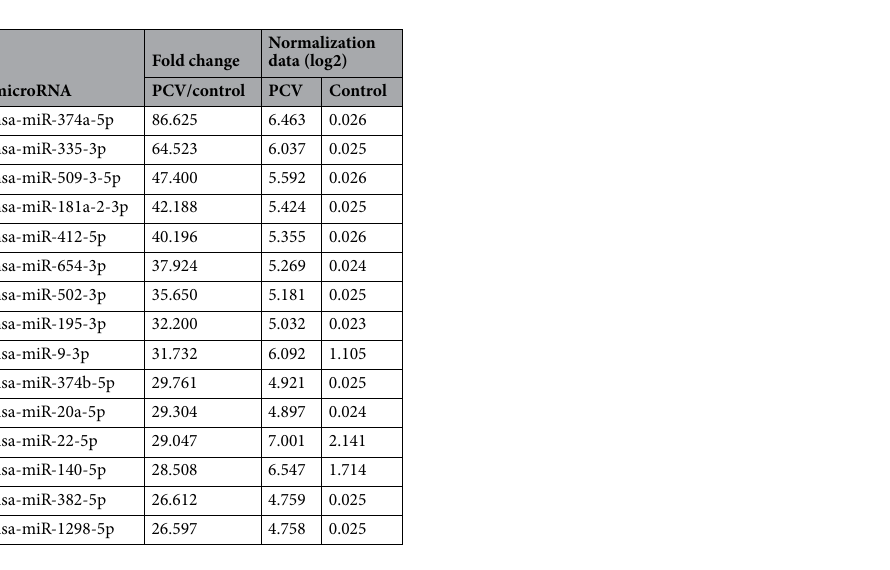
Table 3. Top 15 upregulated miRNAs in PCV. PCV polypoidal choroidal vasculopathy.